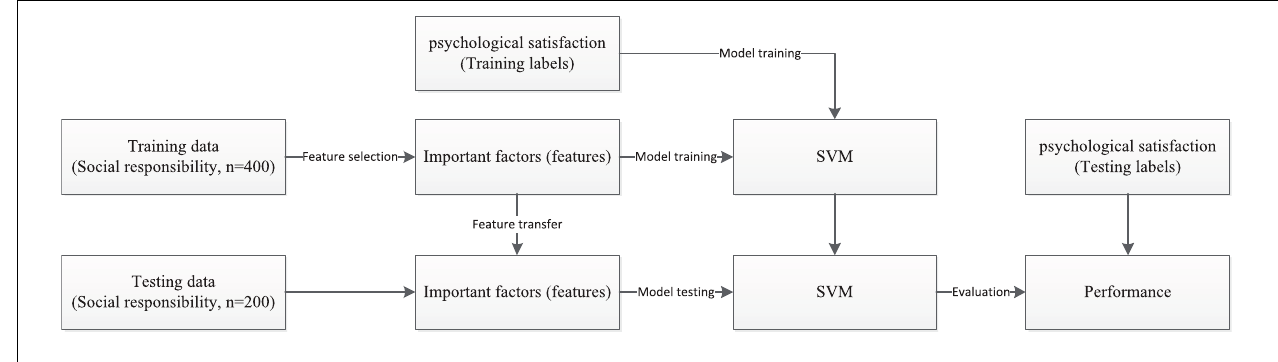
FIGURE 1 | Experimental workflow.